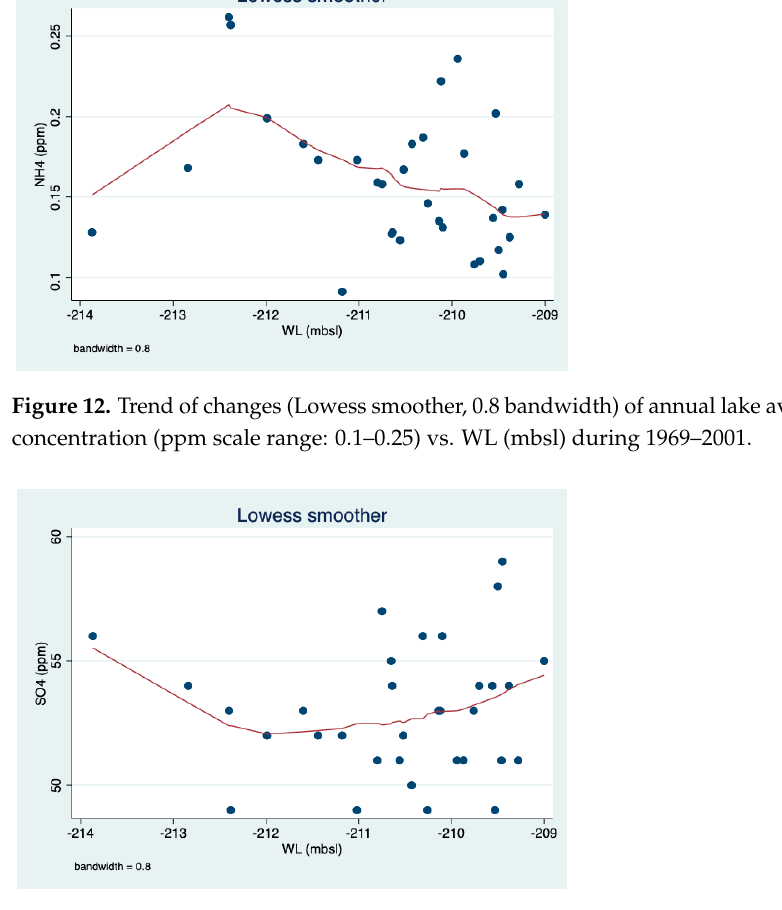
Figure 13. Trend of changes (Lowess smoother, 0.8 bandwidth) of annual lake averages of sulfate (SO 4 ) concentration (ppm) vs. WL (mbsl) during 1969–2001.